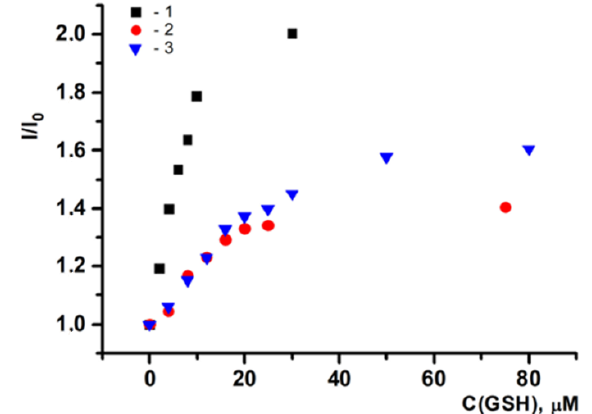
Figure 3. The I/I 0 values (I 0 and I are the fluorescence intensities at 530 nm of SNs-NH 2 -Cu II -CDs itself and at different concentrations of GSH) versus GSH concentration in water for SNs-NH 2 -Cu II - CDs (1, 0.05 gL −1 , 1 μ M of Cu II ) and Cu II -CDs (2, 3) at 30 μ M (2) and 300 μ M (3) of CuCl 2 and C CD = 0.005 gL −1 .